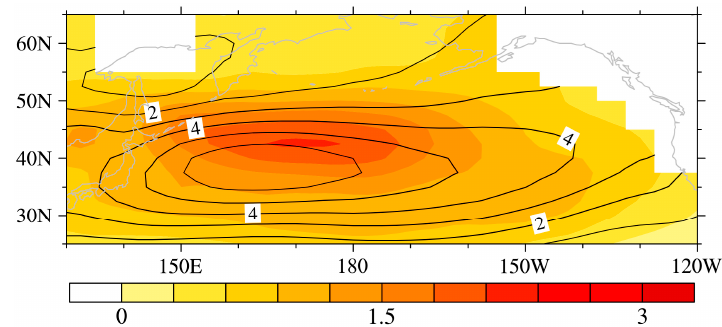
Figure 3. The multi-model ensemble (MME) of simulated climatological WNPST amplitude (contour) and standard deviation (spread) of these 13 models (shading).